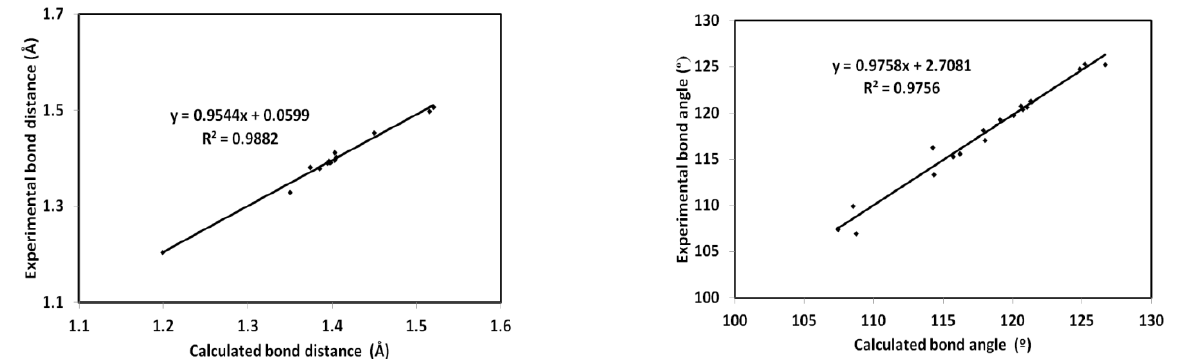
Figure 8. Correlations between the optimized and experimental geometric parameters.